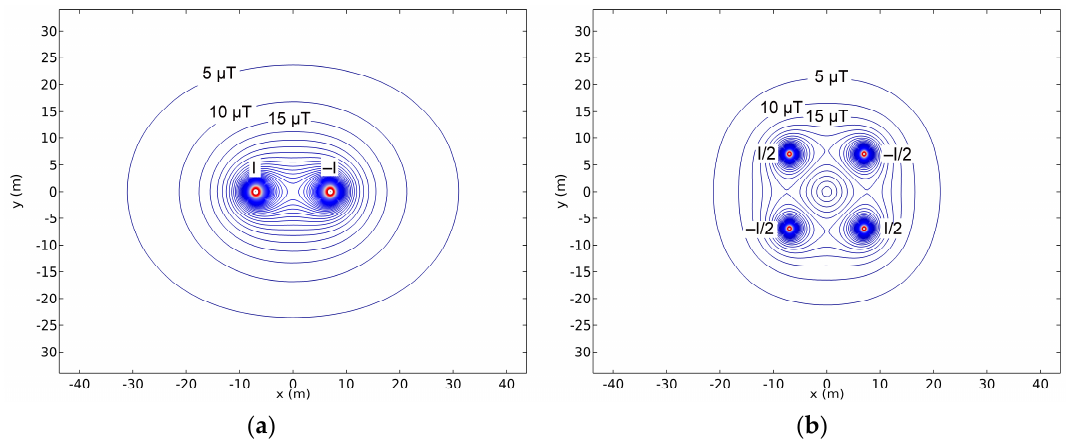
Figure 3. MF levels for a line arranged as a ( a ) dipole and ( b ) a quadrupole line (based on [13], CIGRÉ 2009).